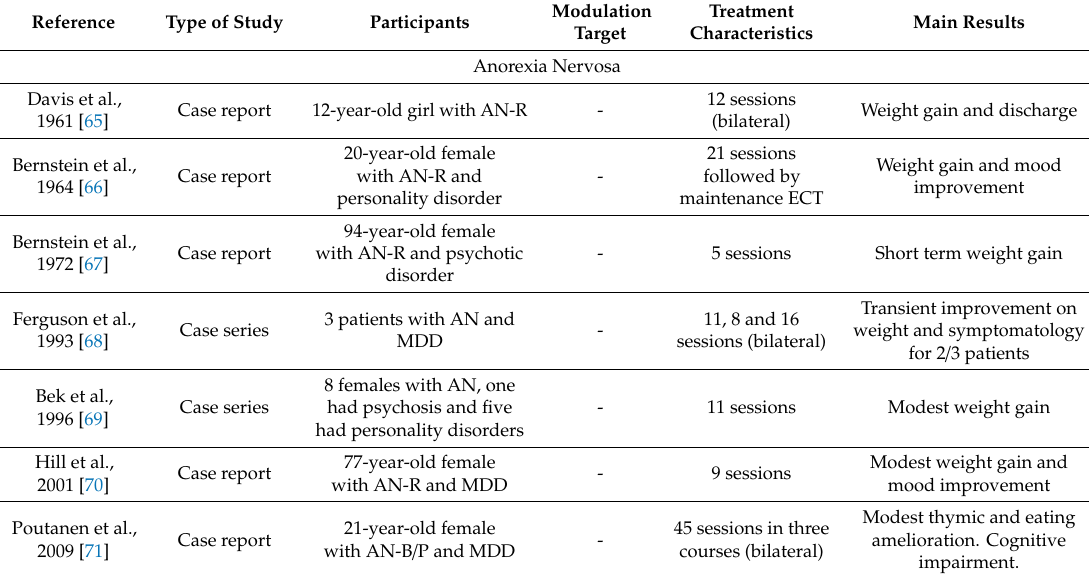
Table 3. Electroconvulsive therapy (ECT) and eating